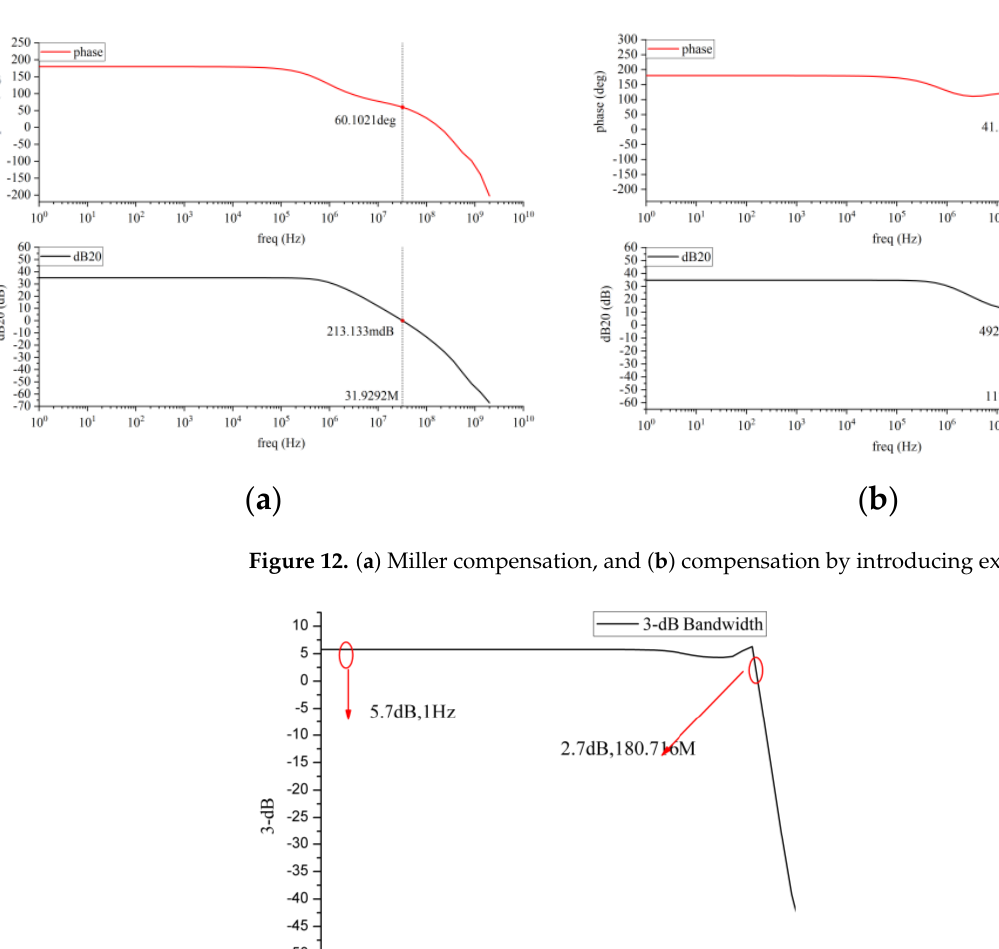
Figure 11. the basic architecture of the hybrid power supply modulator.